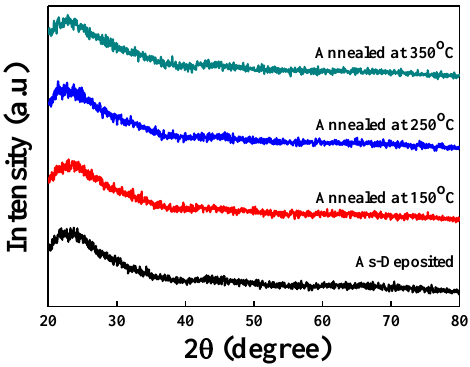
Figure 1. X-ray diffraction patterns of the indium zinc tin oxide (IZTO) films deposited at room temperature onto glass substrates at various annealing temperatures in the range of 150–350 °C. Table 1. Root-mean-square values of the IZTO films from atomic force microscopy (AFM) data.